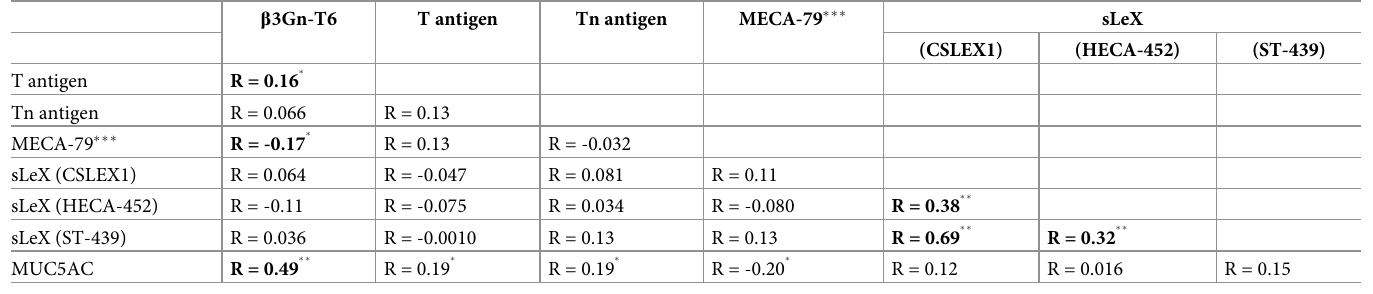
Table 4. Correlations among glycans and related proteins (Spearman’s correlation coefficient